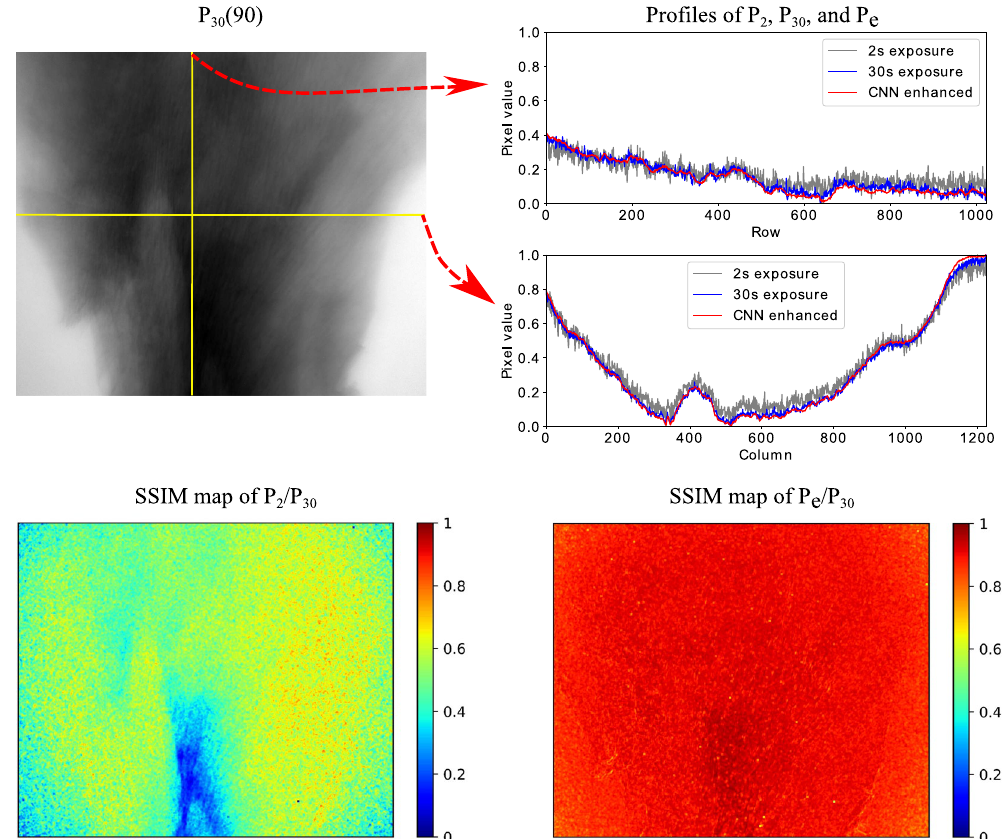
Figure 5. An example of the mouse brain projections with 2 s exposure time, 30 s exposure time and the enhanced projection with CNN. The top left image is the projection with 30 s exposure time at 90°. The top right are the profiles of the projections with 2 s (gray line), 30 s (blue line) exposure time, and the 2 s projection enhanced with CNN (red line). The profiles locations are as the yellow lines of the top left image. The maps of the bottom are the SSIM maps of P 2 (90)/ P 30 (90) and P e (90)/ P 30